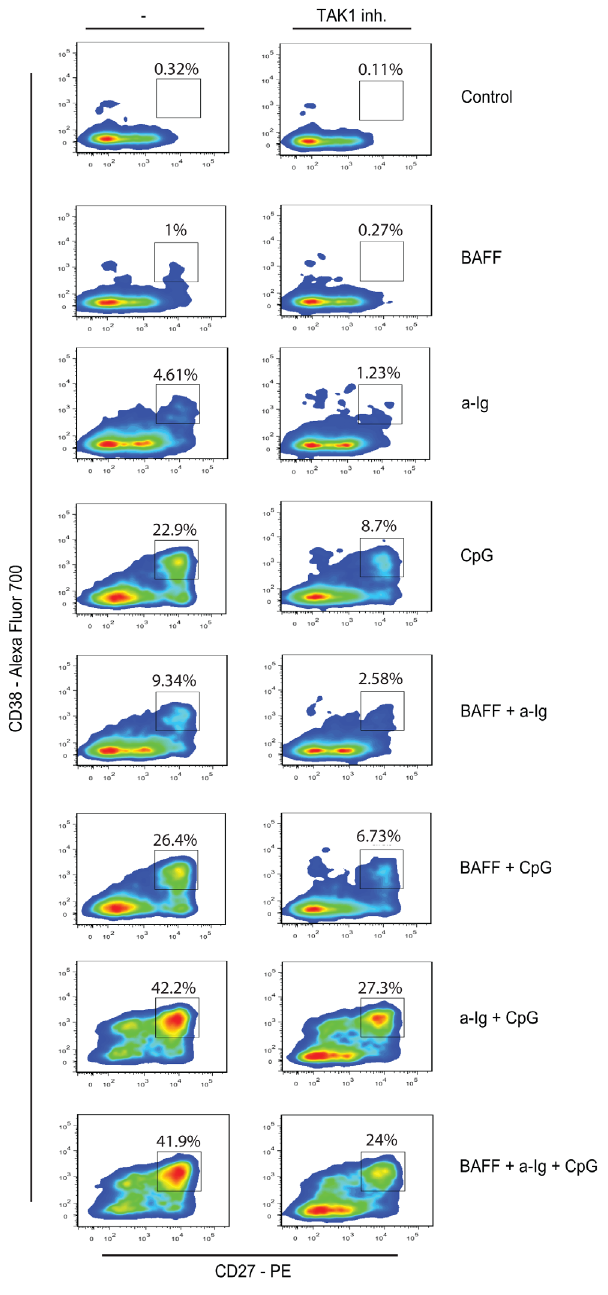
Figure 6. Plasma blast generation induced by single or combined stimuli of B cells via BCR, TLR9 and BAFF-R is partially inhibited by (5Z)-7-Oxozeaenol. Purified B cells (2 6 10 5 cells/well) were cultured with anti-Ig (2.5 m g/ml), BAFF (100 ng/ml) and CpG (0.5 m g/ml) for 4 days in the presence of IL-2 (50 ng/ml) and IL-10 (50 ng/ml). Percentages of CD27 ++ CD38 + plasma blast cells were evaluated by flow cytometry. Samples in the right column were treated with 5Z-7 Oxozeaenol (100